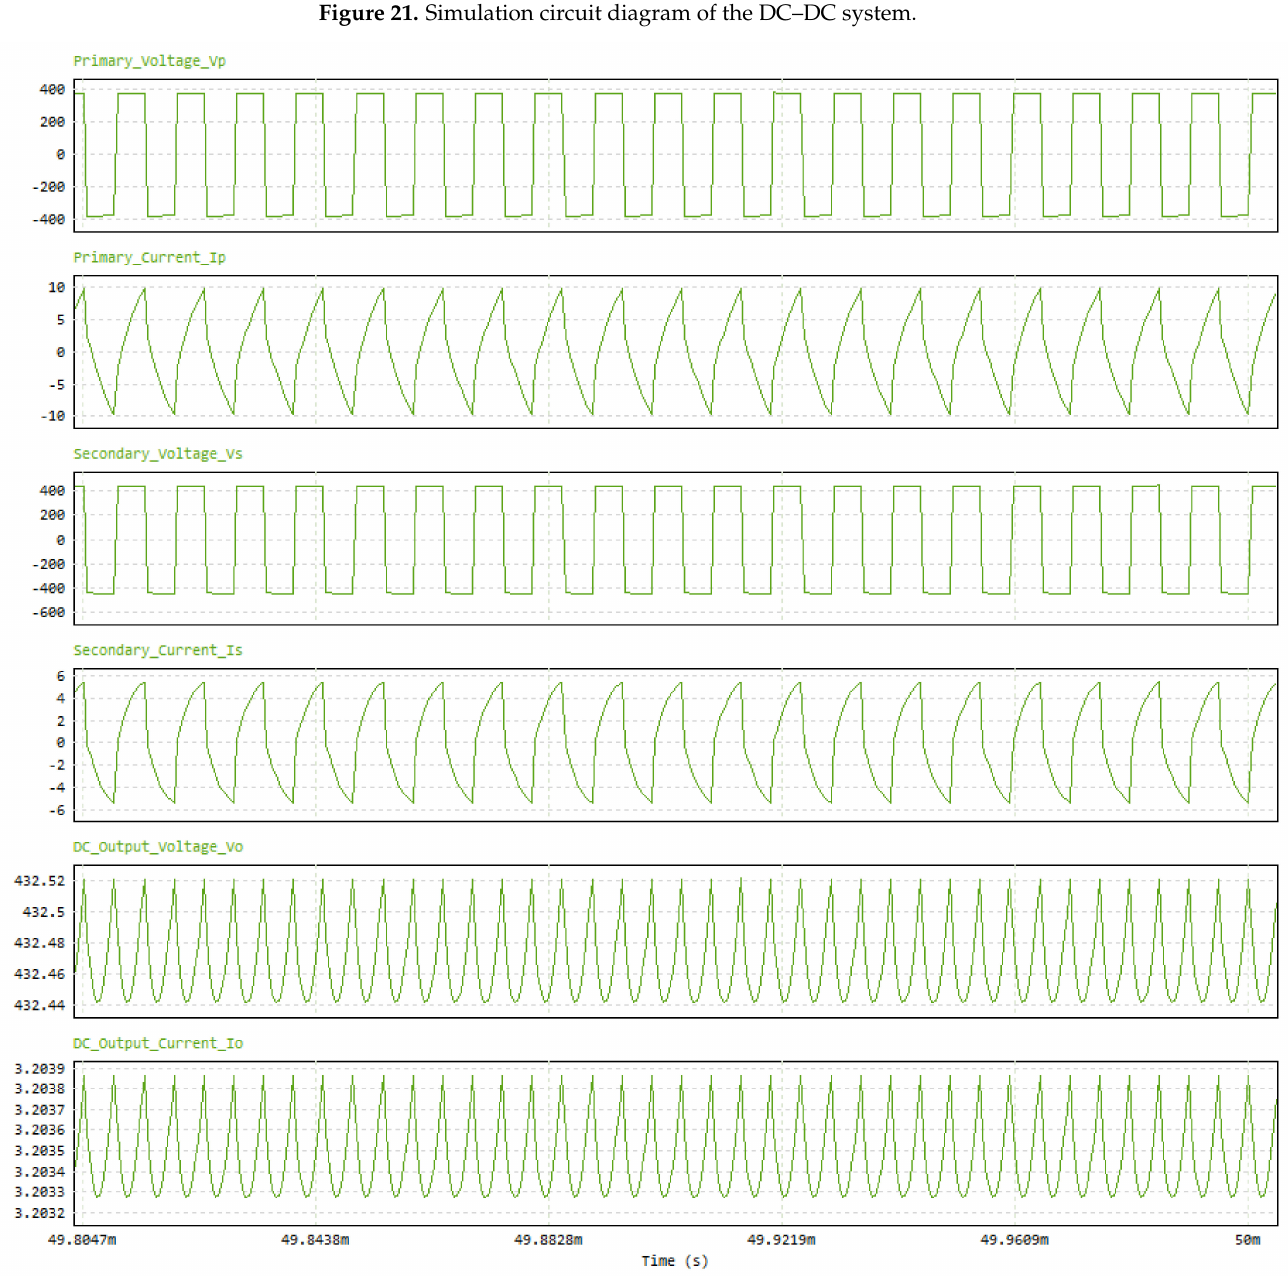
Figure 21. Simulation circuit diagram of the DC–DC system.